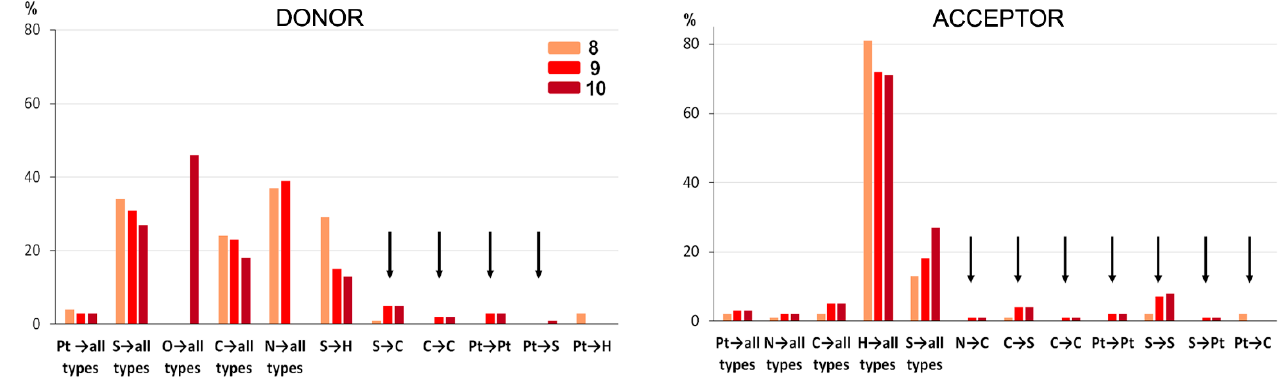
Figure 6. Percentage contribution of the various intermolecular contacts exchanged by the donor moiety and by the acceptor moiety with the surrounding environment for complexes 8 – 10 are reported as colored bars. The arrows indicate interactions occurring between atoms that are part of planar and electronically delocalized systems.